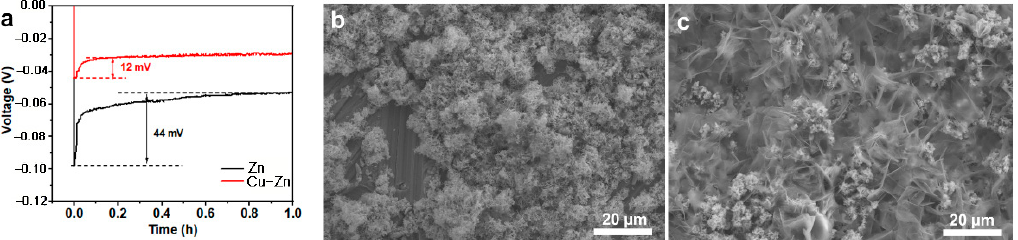
Figure 4. ( a ) The voltage-time curves during Zn nucleation and deposition on Zn and Cu–Zn at 1 mA cm − 2 , SEM images of ( b ) Zn and ( c ) Cu–Zn after Zn-depositing with a capacity of 2 mAh cm − 2 at current density of 1 mA cm − 2 .